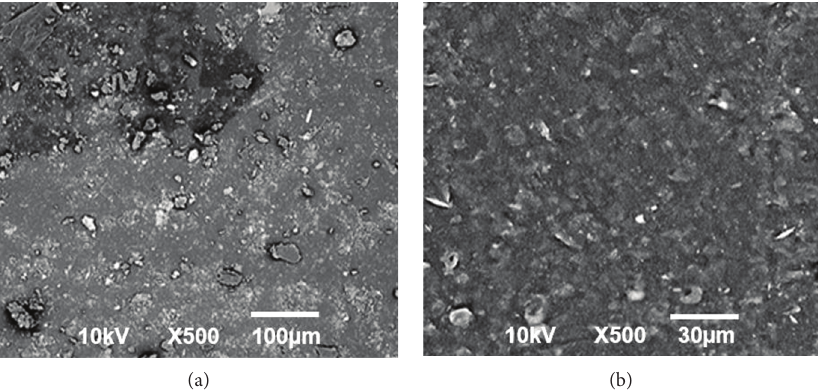
Figure 6: Representative SEM images of (a) untreated BFF fibers/polypropylene polymer composite and (b) alkali-treated BFF fibers/polypropylene polymer composite.